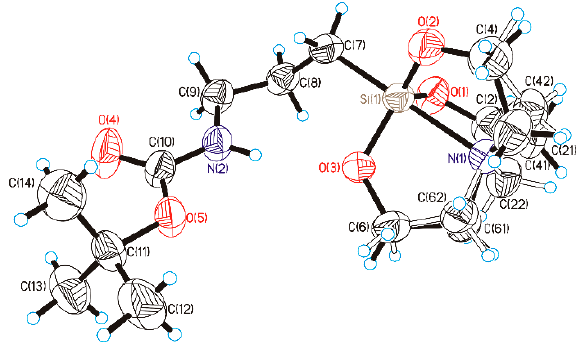
Figure 2. Molecular structure of BocAPS. Displacement ellipsoids are shown at the 50% probability level.